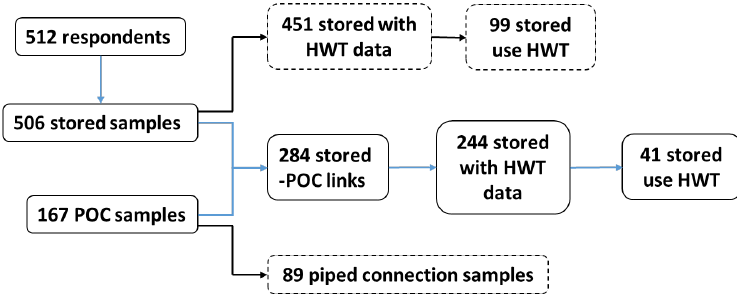
Figure 5. Schematic flow of the water-quality analysis showing the link between stored samples and POC samples, the number of POC samples coming from a piped connection, and the number of stored samples coming from treated water.